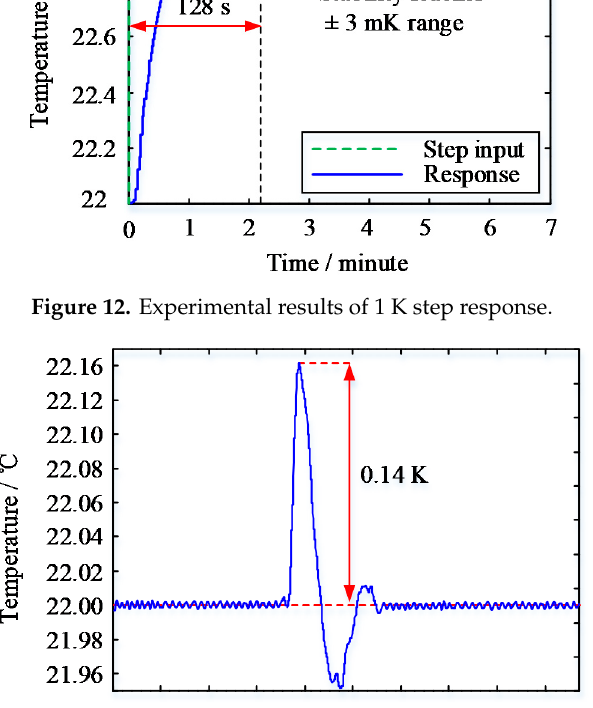
Figure 12. Experimental results of 1 K step response.